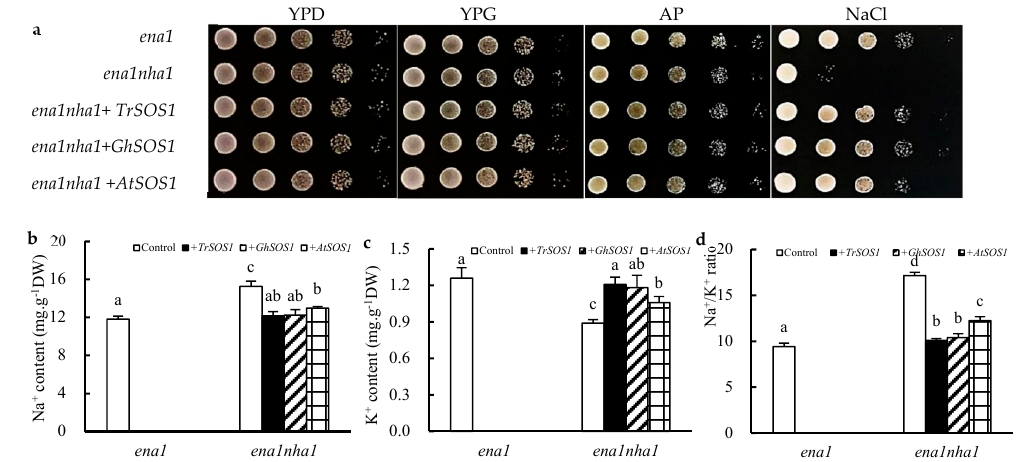
Figure 5. Effects on the growth phenotype ( a ), contents of Na + ( b ), K + ( c ), and Na + /K + ratio ( d ) of the yeast strains ena1 , ena1nha1 , and ena1nha1 complemented by TrSOS1, GhSOS1, and AtSOS1 under NaCl treatment. Different lowercases in the same group indicate the significant differences ( p ≤ 0.05).